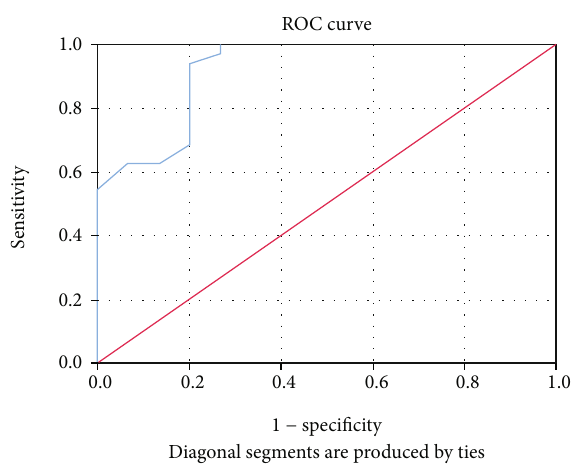
Figure 7: ROC curve for the 25-OHD level to predict improvement in HE group (patients who have recovered and did not die) (A fifi , Hussein, and Rizk, 2020).